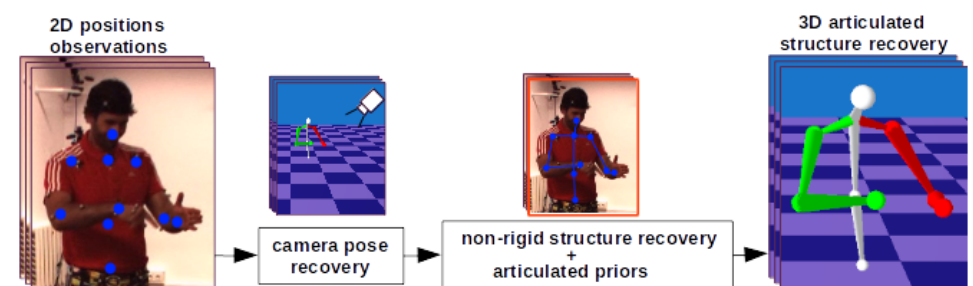
Figure 3. The pipeline of the proposed SfAM approach. Following factorization-based NRSfM, we first recover the camera pose using 2D position observations. Then, we recover 3D articulated structure by optimizing our new energy functional accounting for articulated